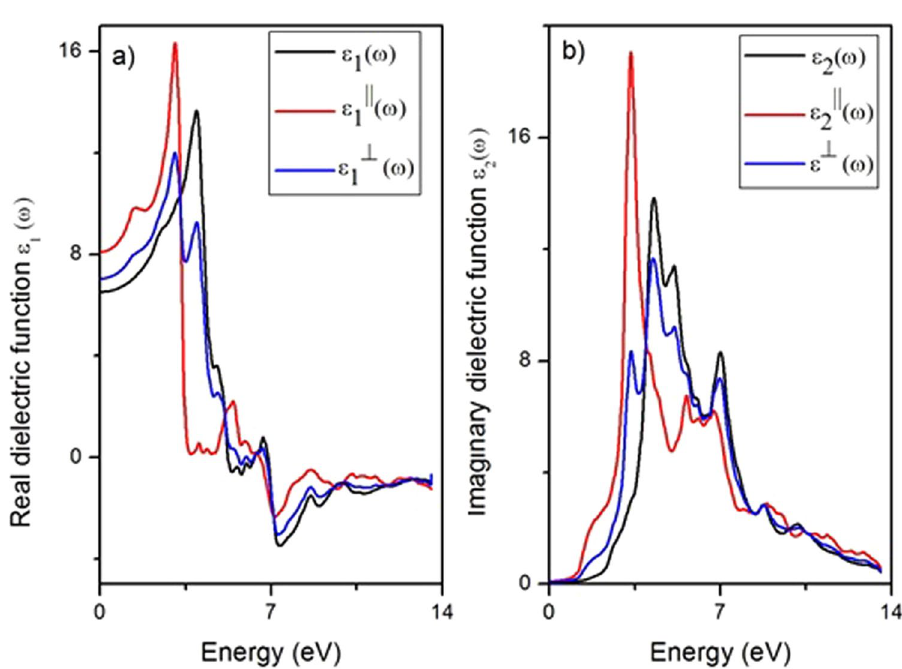
Figure 5. The real ( a ) and imaginary ( b ) parts of the dielectric function obtained from the dielectric theory. Each curve is referred to the total (black), parallel (red) and perpendicular (blue) components,